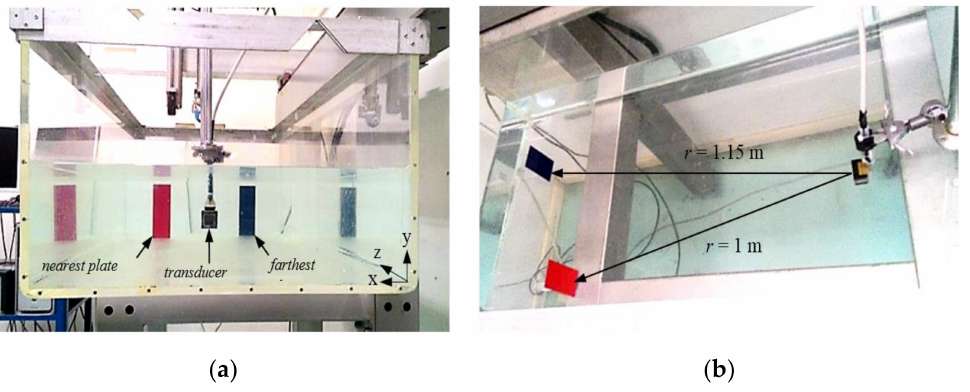
Figure 21. ( a ) Front view and ( b ) Top view of the experiment with faraway targets: pulse echoes from two aluminum plates of 60 mm × 160 mm immersed in a water tank of 1.4 m x 0.6 m filled up 0.2 m, were acquired with the 2-D array.